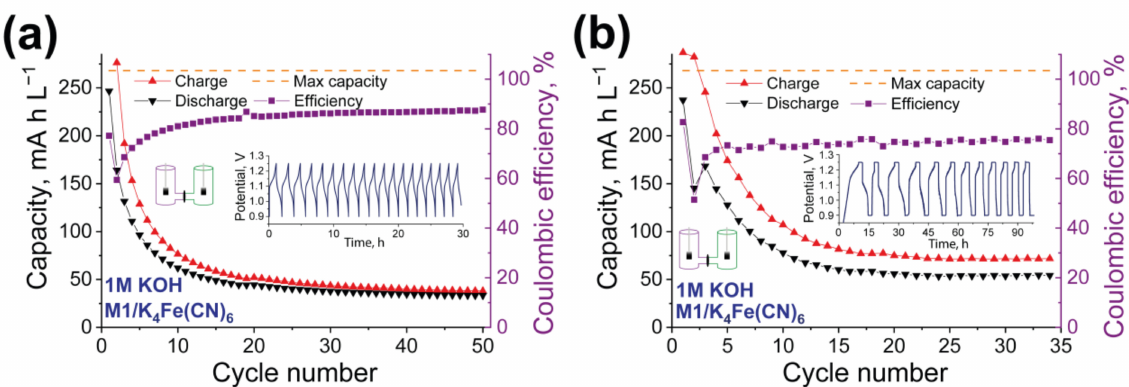
Figure 5. Electrochemical performance of h-cell with 5 mM M1 anolyte and 15 mM K 4 Fe(CN) 6 + 7.5 mM K 3 Fe(CN) 6 catholyte in 1.0 M KOH water solution. Neosepta AHA membrane was